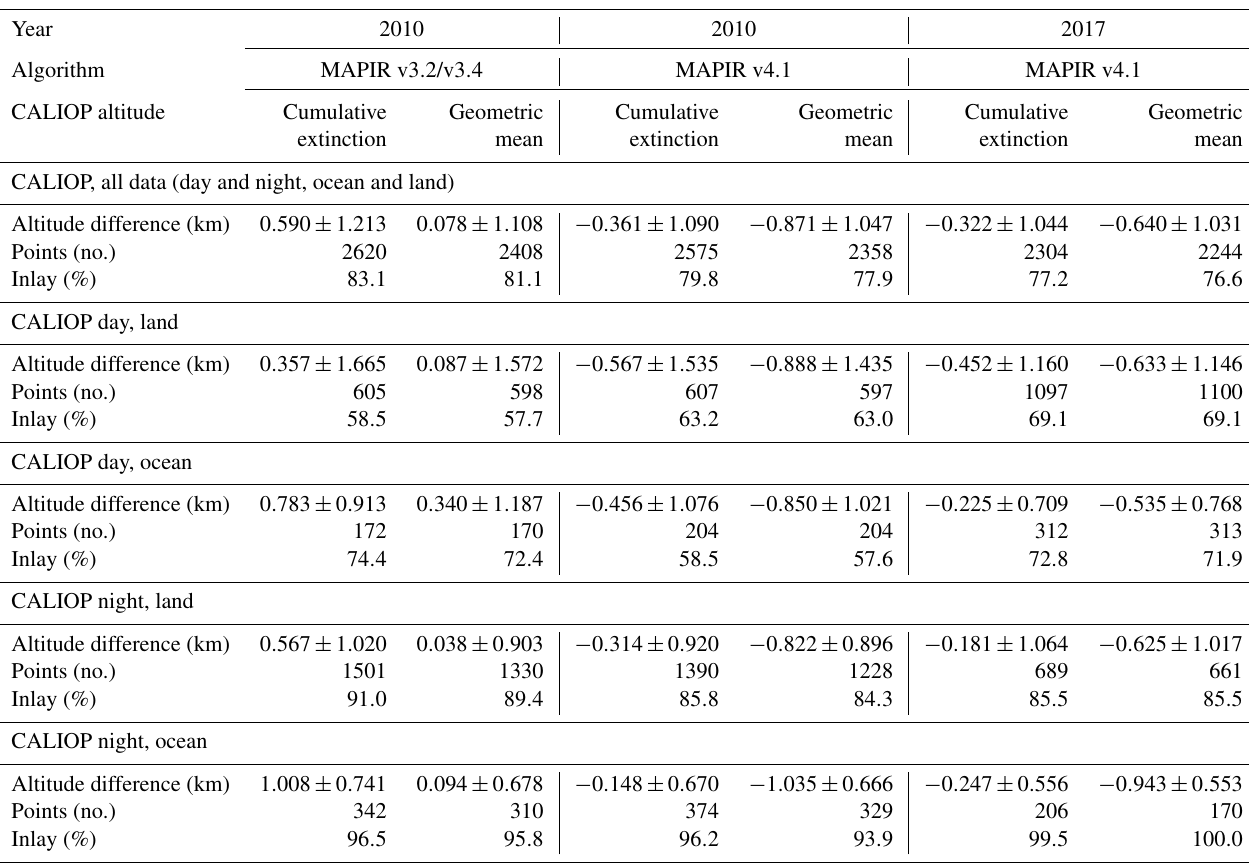
Figure 7. MAPIR AOD, converted to 550nm, versus the AERONET SDA coarse-mode AOD difference distribution. (a) Scatter plot of the AOD difference in function of the AERONET AOD (red dots), for all considered stations combined. Data are split into 10 bins of equal quantity; corresponding binned median (black dots) and interquartile range (IQR, vertical black lines) are shown. (b) AOD difference histogram. Table 1. The mean ± the standard deviation of the dust altitude difference between the MAPIR and CALIOP dust altitudes and the number (no.) of co-located points. The inlay is the percentage of MAPIR altitudes that are within the CALIOP layer. MAPIR 3.2/3.4 results are taken from Kylling et al.